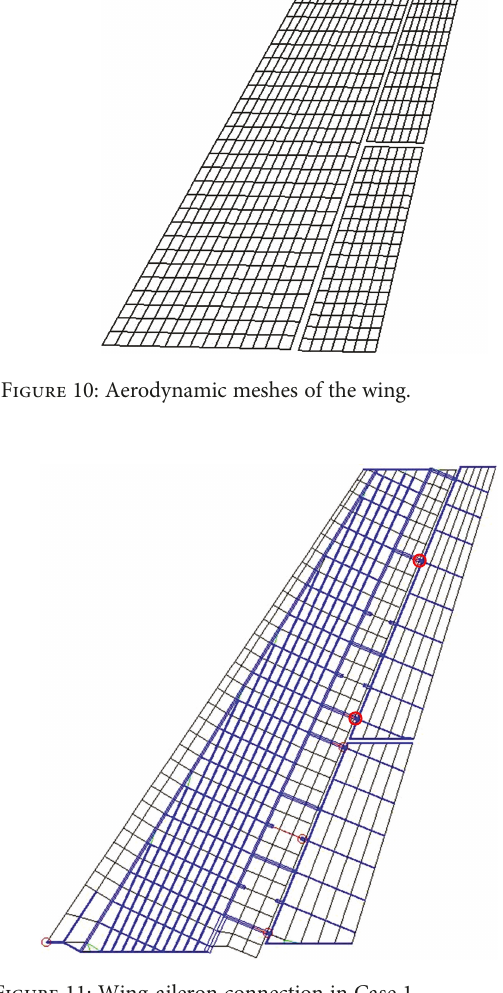
Figure 11: Wing-aileron connection in Case